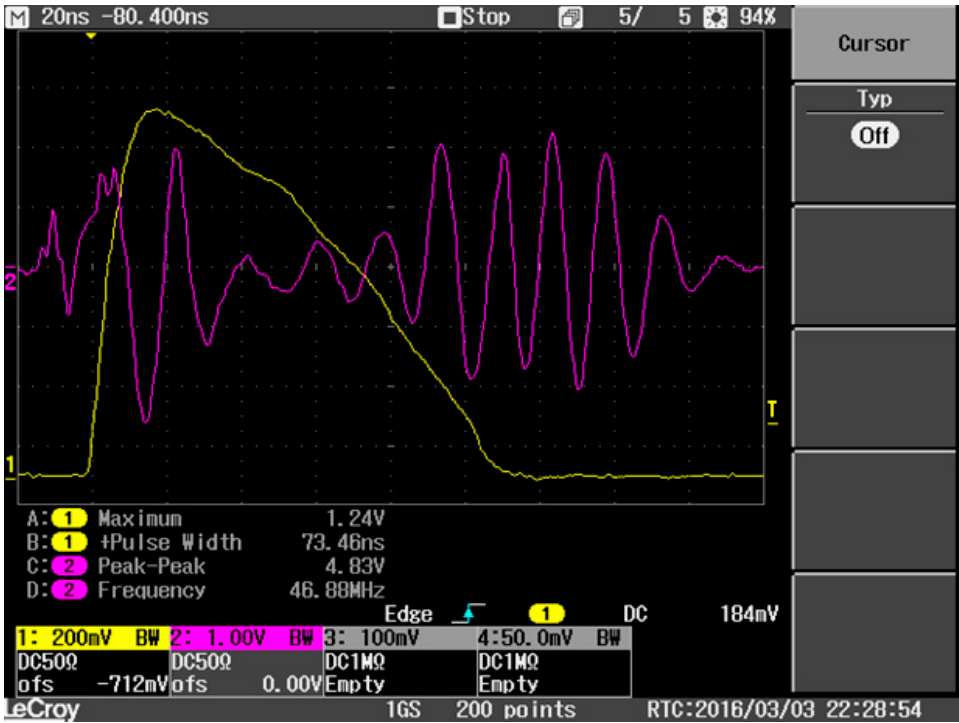
Figure 3. Measurement of the radar pulse (yellow line) and intermediate frequency of the signal at the front end. In this case the pulse width is approximately 73 ns giving an acceptable power and pulse shape.